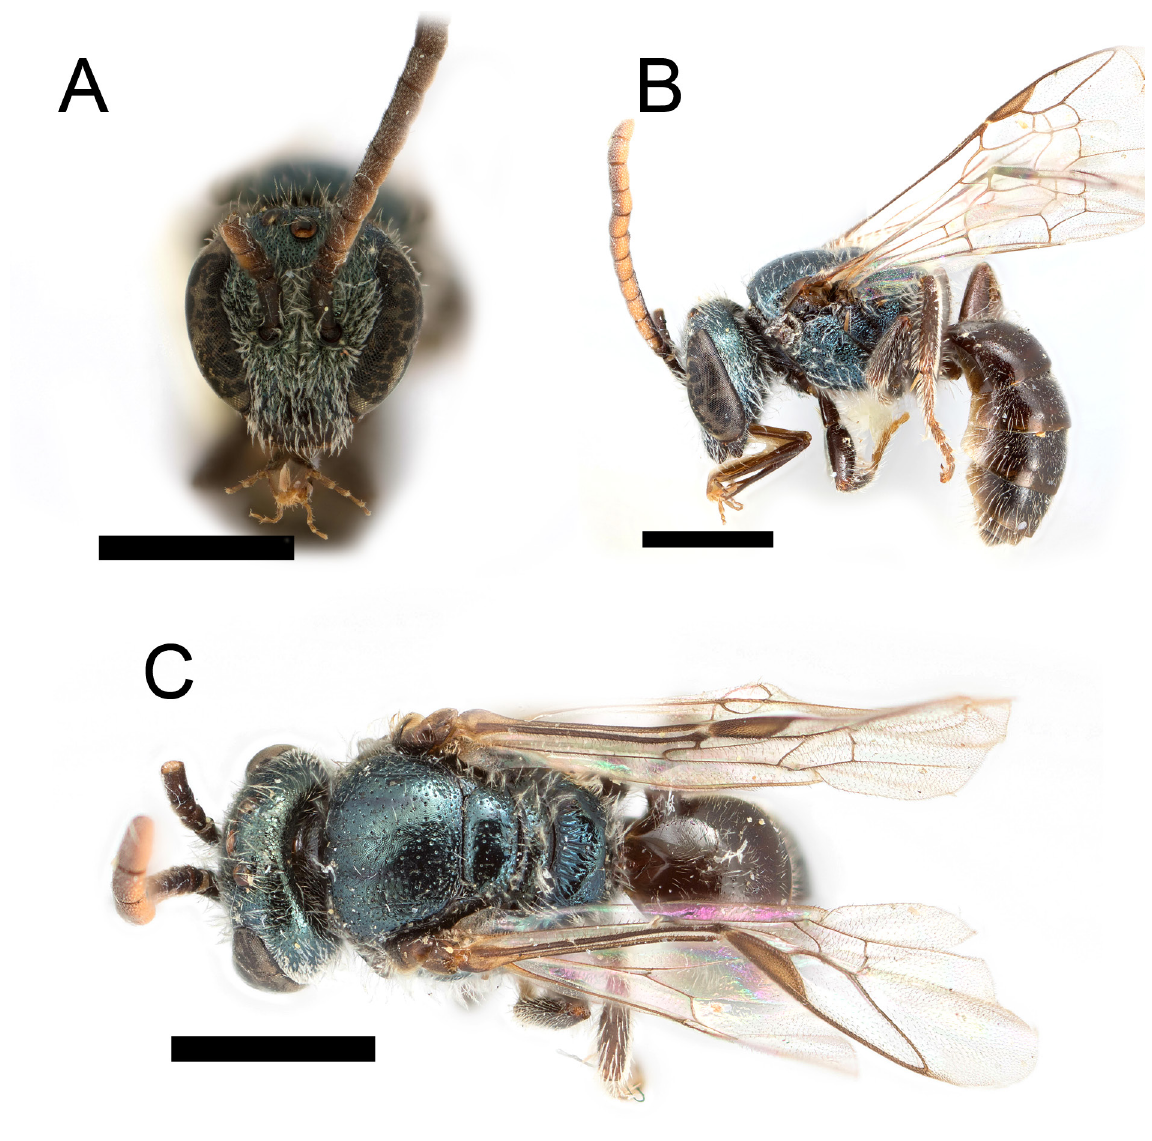
Fig. 3. Lasioglossum dispersum sp. nov., ♂. A . Face. B . Lateral habitus. C . Dorsal habitus. Scale bars = 1